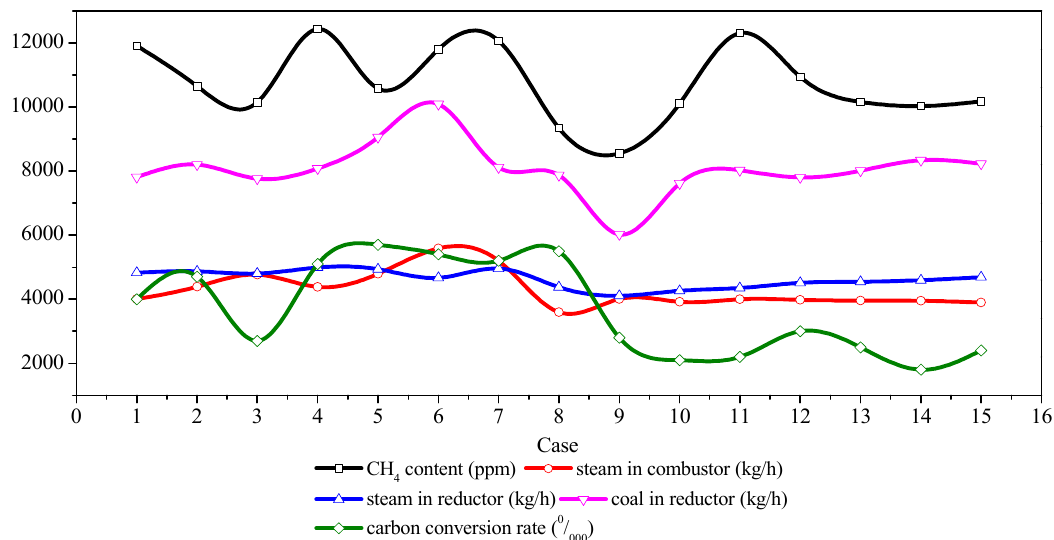
Figure 5. The effect of coal operation data to carbon conversion rate in reductor.